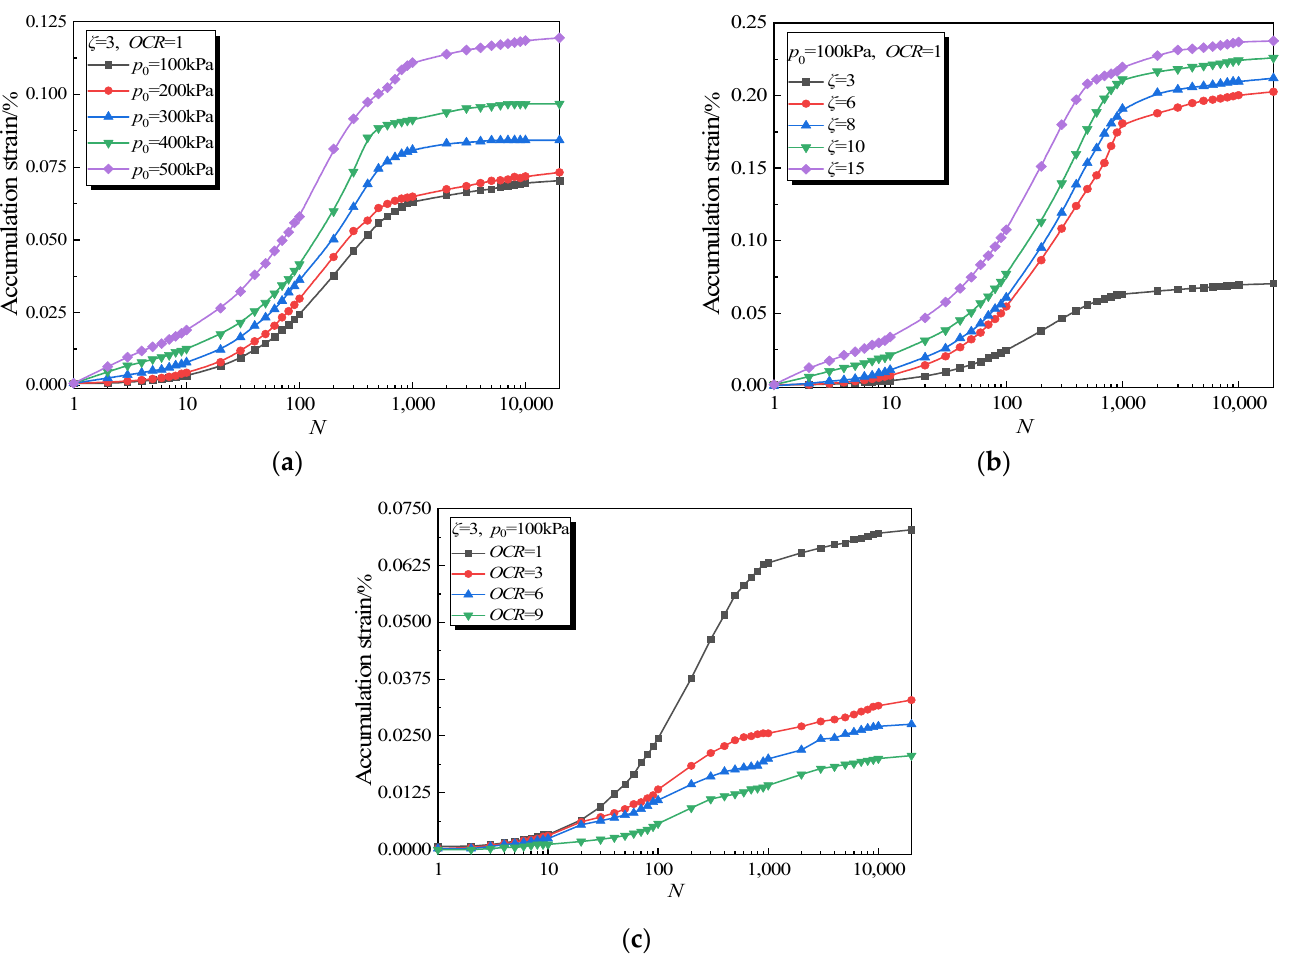
Figure 5. Cumulative strain-vibration curve in different dynamic load modes [16]: ( a ) group A; ( b ) group B; ( c ) group C. ( b ) group B; ( c ) group